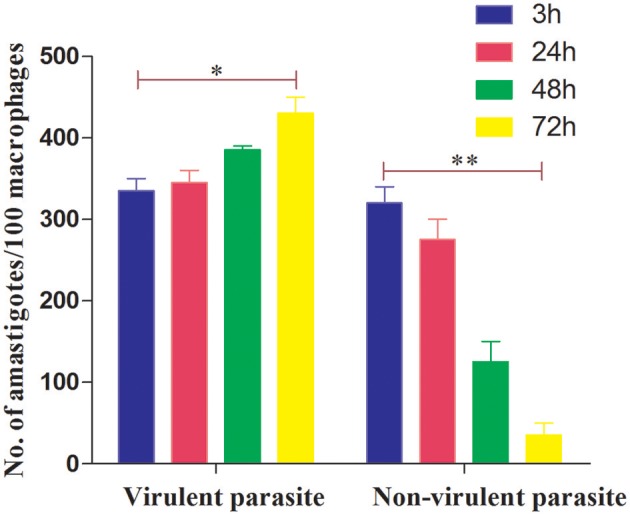
Dynamics of murine macrophage infection with virulent and non-virulent L. donovani promastigotes. Murine macrophages were infected with either virulent (2nd passage) or non-virulent (25th passage) L. donovani promastigotes for 3 h, washed, and further incubated until 24, 48, and 72 h p.i. The number of internalized parasites in 100 macrophages was determined microscopically by Giemsa staining. The results are expressed as mean S.E (n = 3). *P < 0.01, **P < 0.001.